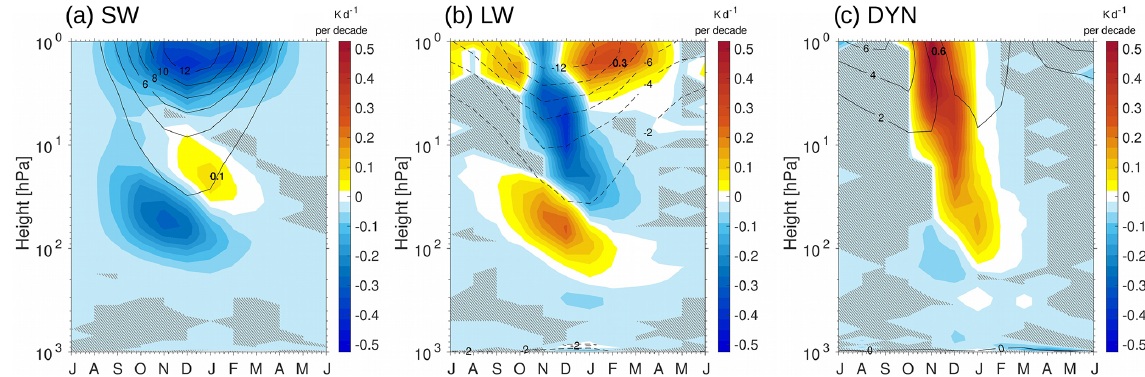
Figure 6. Polar cap (65–90 ◦ S) linear (a) SW, (b) LW and (c) DYN heating rate trends in kelvin per day per decade as function of height for the ensemble mean of Chem ON for the time period 1969–1998 (shading). The particular climatologies (contours) are represented for the same period with an interval of 2Kd − 1 . Statistically insignificant regions are hatched at the 5% level based on a Mann–Kendall